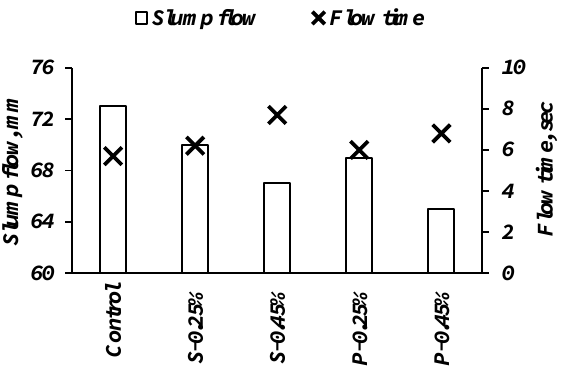
Figure 5. Results of slump flow diameter and V-funnel times.